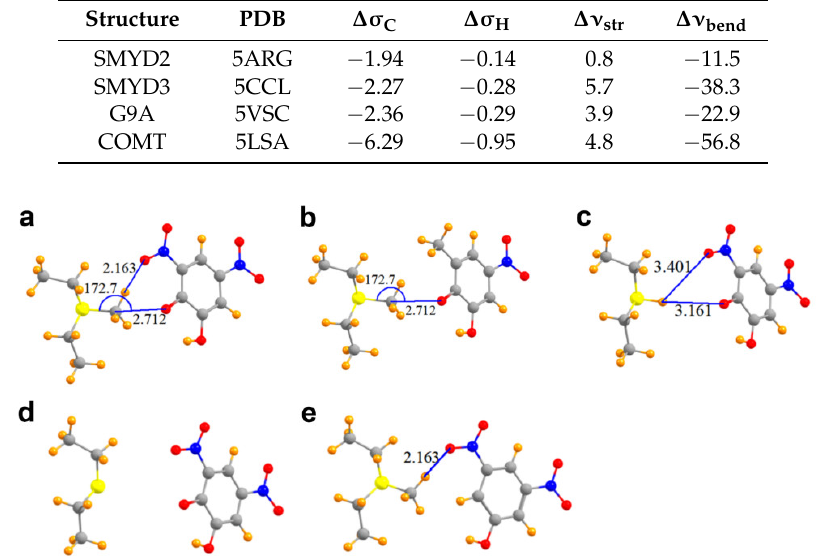
Figure 4. Molecular structures of COMT models used to probe C ··· O tetrel bonding between AdoMet and DNC. ( a ) MeS + (Et) 2 and the phenoxide anion of DNC; ( b ) Model in which the 3-nitro moiety of DNC is replaced with a methyl group; ( c ) Complex wherein the methyl group of MeS + (Et) 2 is replaced with a hydrogen atom, yielding HS + (Et) 2 ; ( d ) Model of DNC and the thioether S(Et) 2 representing the product AdoHcy; ( e ) Complex in which the phenoxide oxygen atom of DNC is substituted by a hydrogen atom.